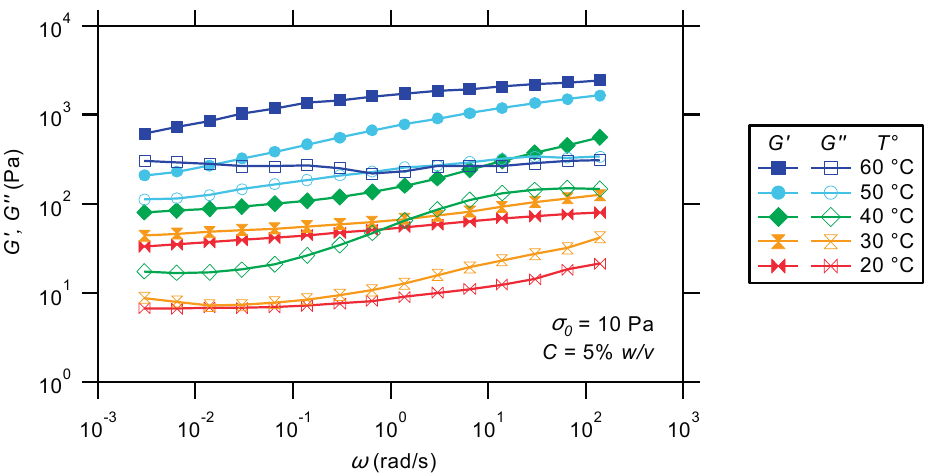
Figure 8. Frequency dependence of dynamic moduli for a hydrogel prepared from the PS- b -PNIPAAm- b -PDMAEMA-tpy copolymer and Ni(II) ions, at different